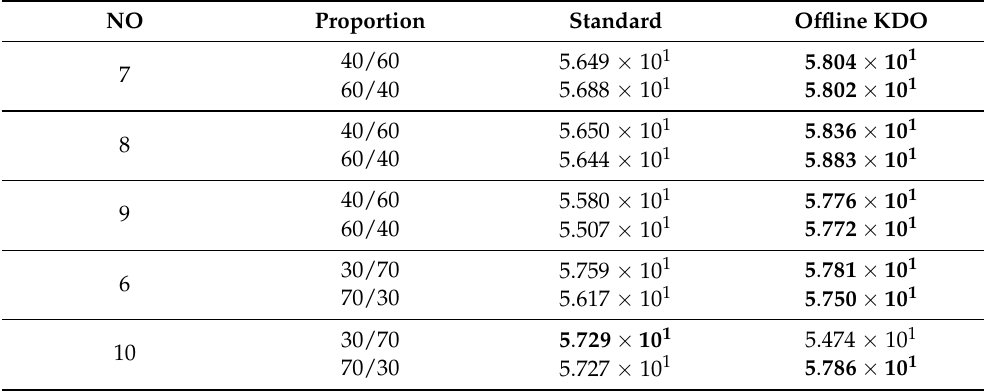
Table 6. Area Under the Curve (AUC) of the convergence plots shown in Figure 8 for the different cases of Number of Operators (NO), proportion, and optimization